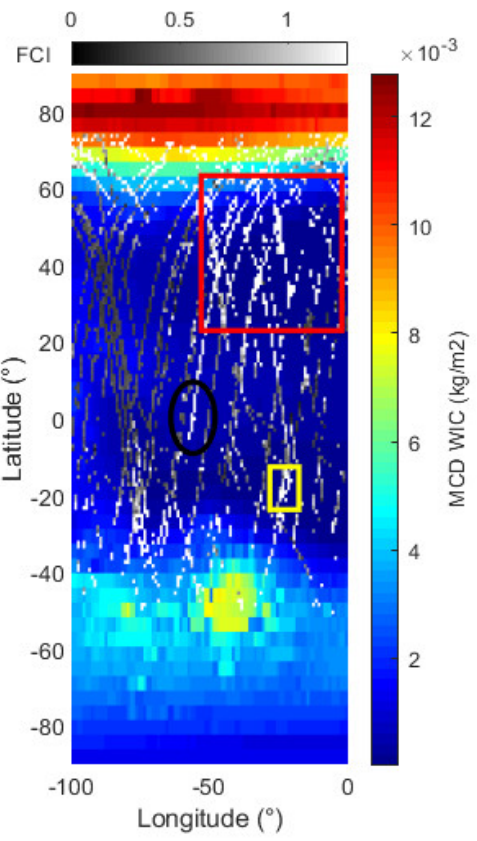
Figure 9. Comparison between the FCI results (grey scale) with the MCD Water Ice Column (colour scale) for all latitudes and longitude from 100°W to 0°. Grey scale: LNO observations in MY35, from L S 30° to 150°. Saturated FCI values are in white (>3.5σ, see Section 4.1). Colour scale: MCD Water ice column simulation for L S 150° and 15 LTST.